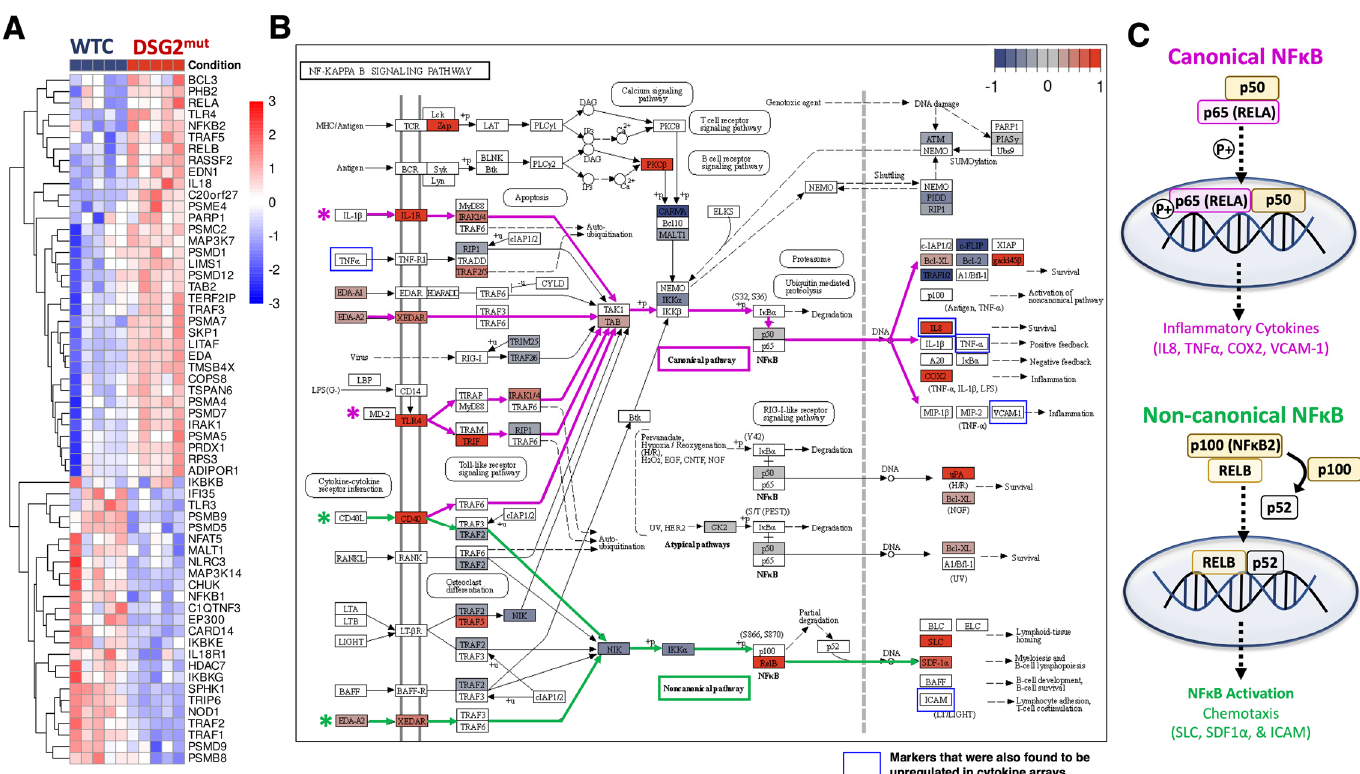
Figure 5. Bulk RNA-Seq analysis reveals both canonical and non-canonical NFkB pathways regulate immune signaling in DSG2 Mut hiPSC-CMs. ( A ) RNA-Seq heatmap analysis and ( B ) KEGG NFkB pathway schematic. For ( A ), we identified genes in the NFkB pathway that were differentially expressed between Ctrl1 and DSG2 Mut hiPSC-CMs (BH-adjusted p -value < 0.05). NFkB pathway genes were identified using genes associated with the gene ontology term “NIK/NF-kappaB signaling” (GO:0038061). Color scale denotes row-scaled log expression values. For ( B ), purple lines and arrows indicate canonical NFkB pathway; green lines and arrows indicate non-canonical NFkB pathway; red shading indicates higher expression in DSG2 Mut relative to control, blue indicates lower expression, and gray indicates no difference. ( C ) Schematic demonstrating canonical NFkB signaling through RELA and non-canonical NFkB signaling through